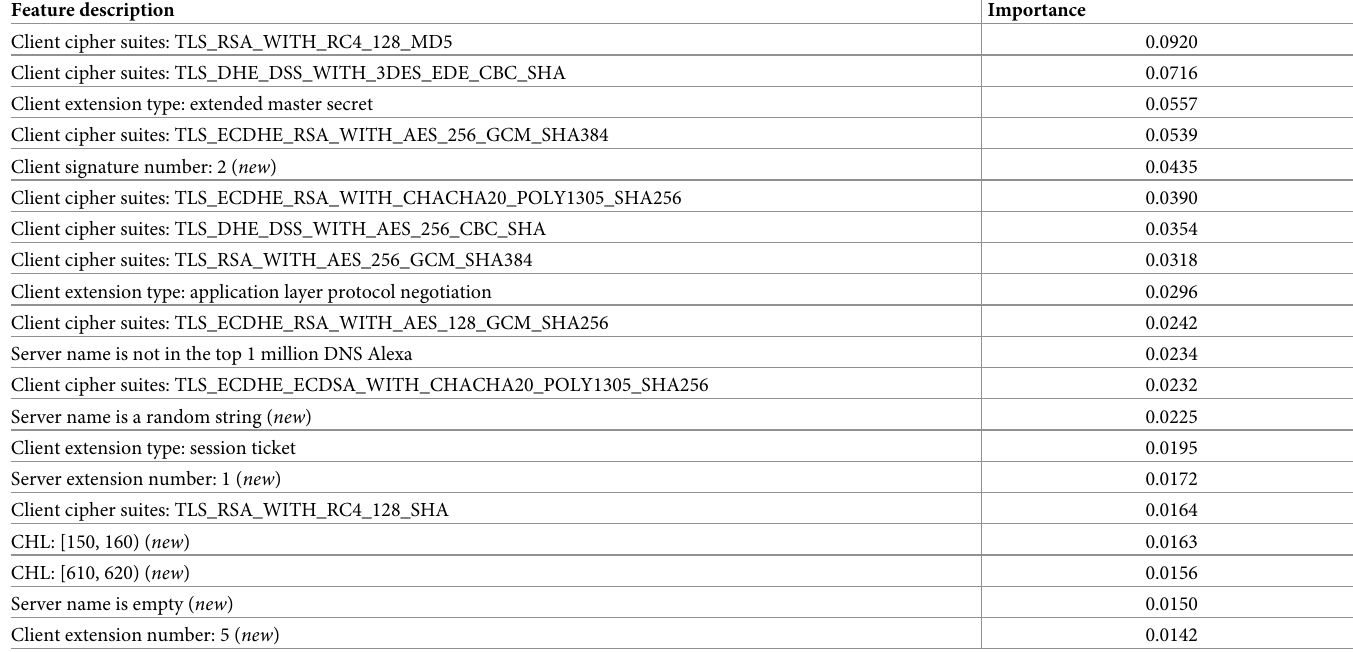
Table 4. The 20 most important features in the filtering